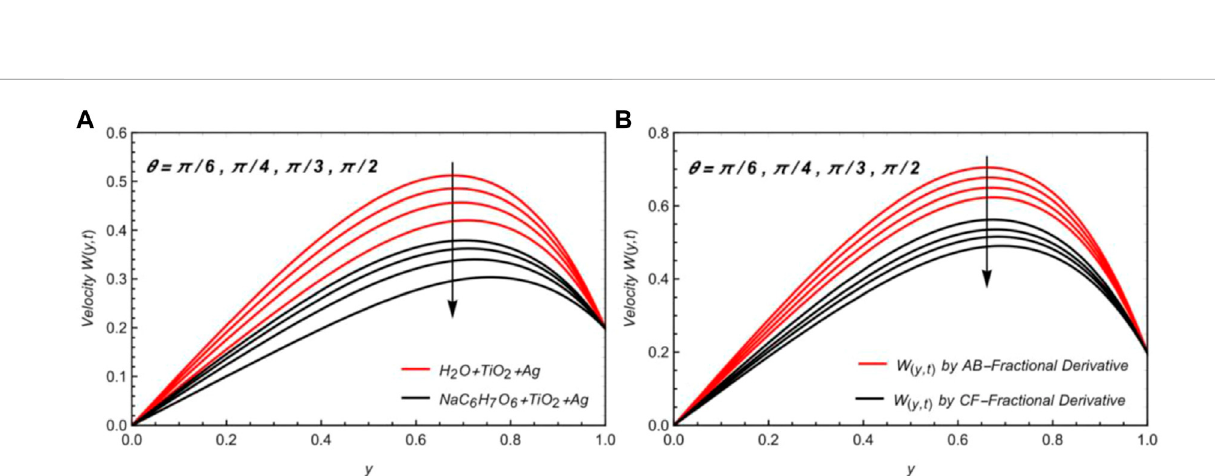
FIGURE 10 W ( y , t ) due to variation in θ with α , β (cid:2) 0 . 5 , φ (cid:2) 0 . 02 , M (cid:2) 1 . 65 , Ra (cid:2) 1 . 2 , K eff (cid:2) 0 . 7 , Gr (cid:2) 8 . 0 , Gm (cid:2) 6 . 3 , β 1 (cid:2) 1 . 5 , and t (cid:2) 0 .